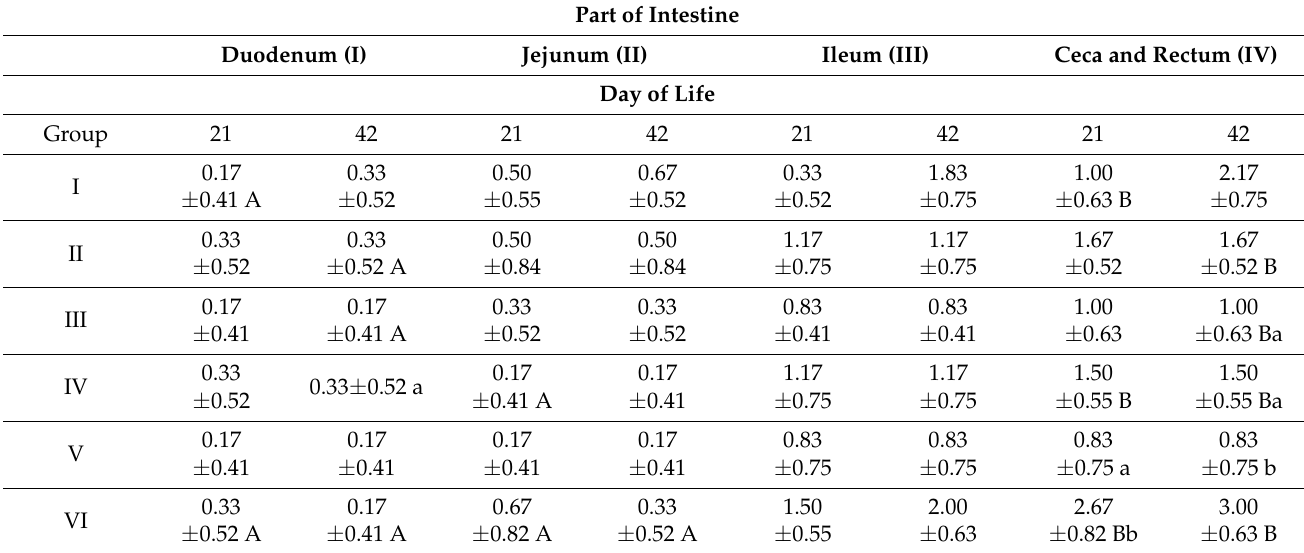
Table 7. Lesion scoring in chicken